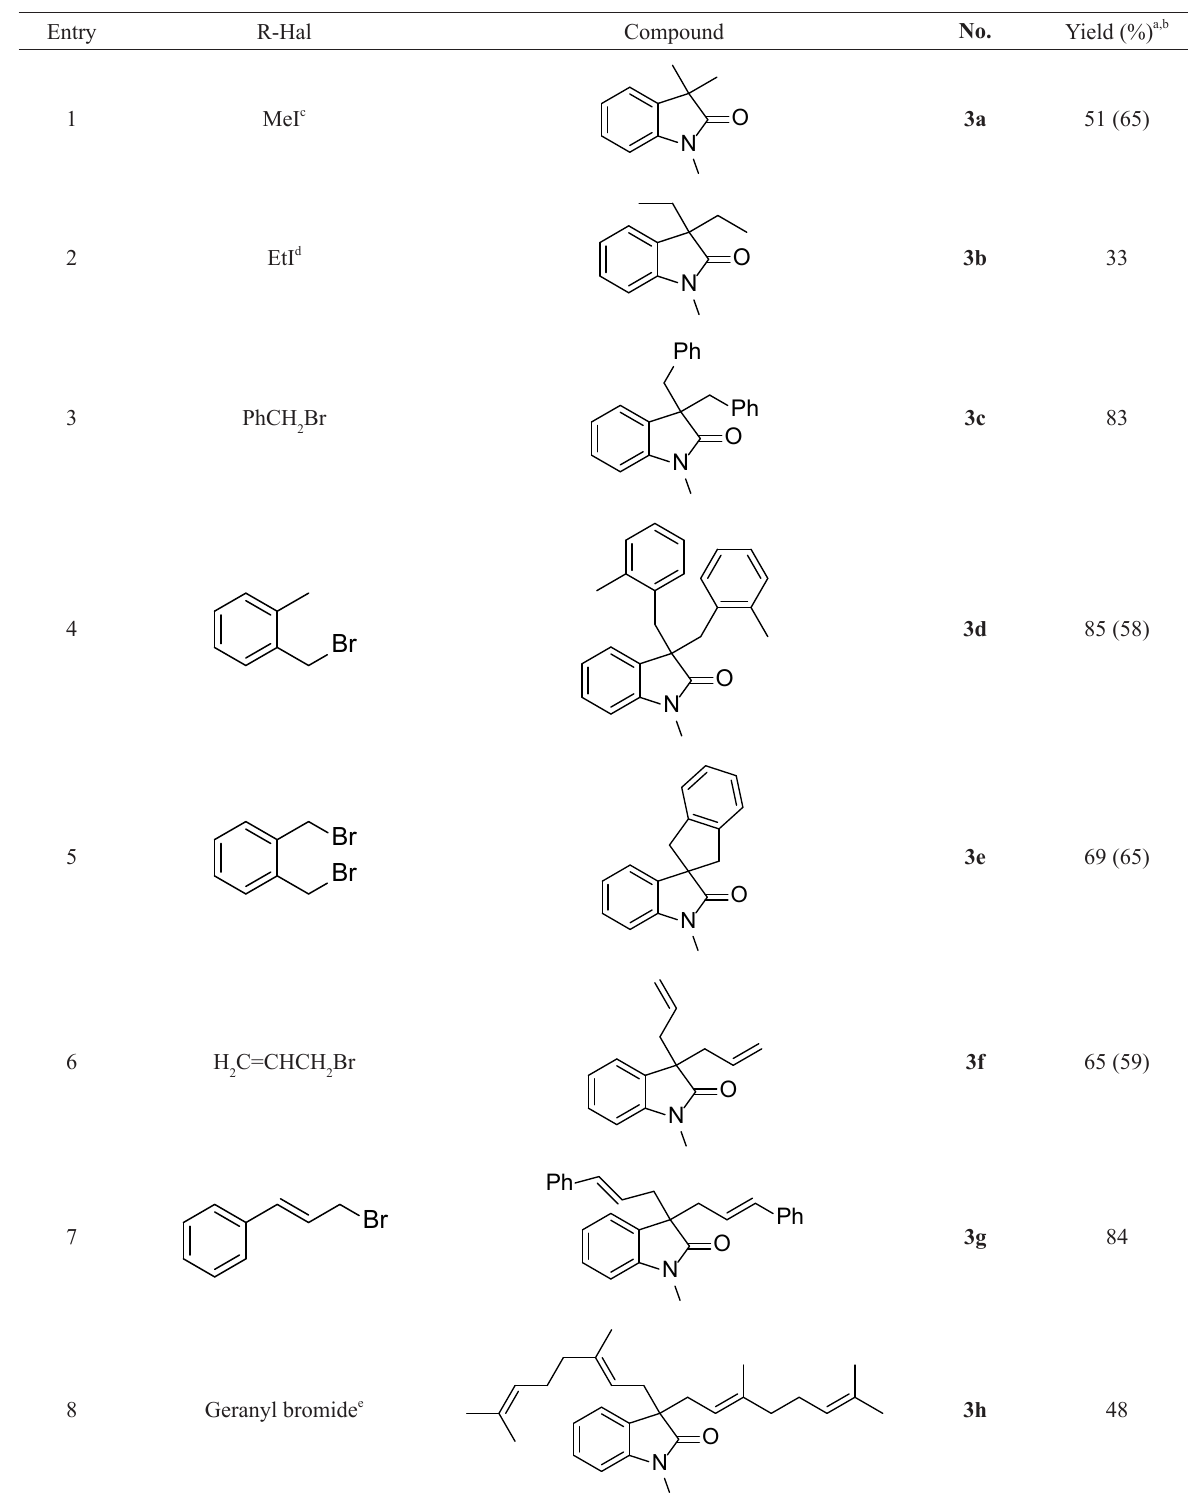
Synthesis of 3,3-disubstituted-2-oxindoles 3 using a DaA of